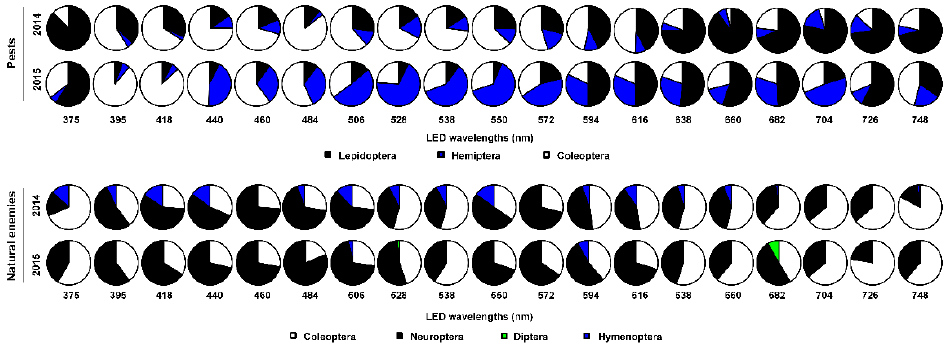
Figure 4. The order compositions of pests and natural enemies trapped in LED-equipped traps with 19 single wavelengths during 2014–2015.